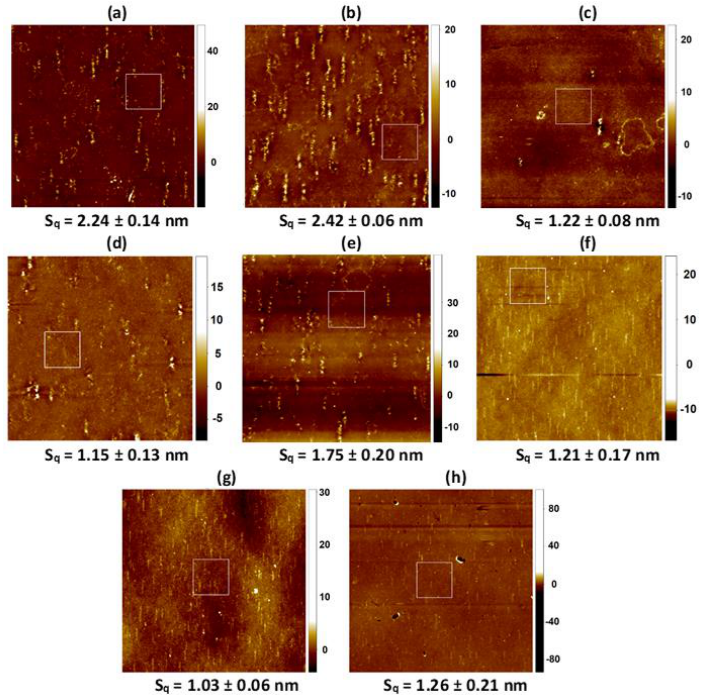
Figure 6. AFM micrographs for the 20 × 20 µ m 2 scanned areas: PET air /Ch ( a ), PET air /Ch/DOPC ( b ), PET air /Ch/CsA ( c ), PET air /Ch/DOPC-CsA 0.50 ( d ), PET air /Ch/DOPC-CsA-LG 0.25 ( e ), PET air /Ch/DOPC-CsA-LG 0.50 ( f ), PET air /Ch/DOPC-CsA-LG 0.75 ( g ), PET air /Ch/LG ( h ). Z scale: nm.